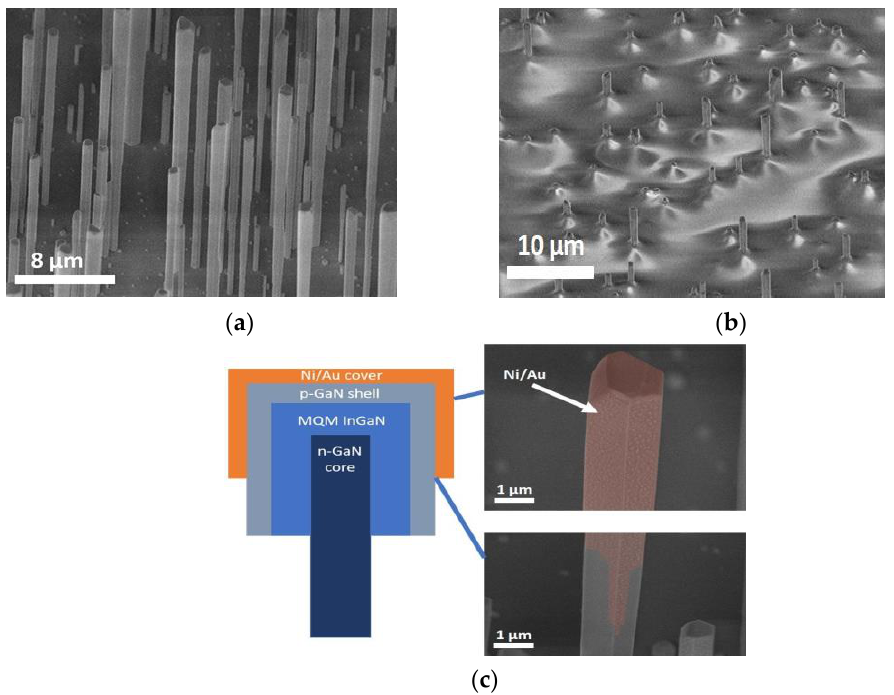
Figure 1. Forty-five-degree tilted SEM images of ( a ) an as-grown MW array, and ( b ) InGaN/GaN microwires encapsulated into PDMS. ( c ) Schematic of InGaN/GaN MQW MW structure with SEM images of a MW tip and the border of an area metalized with Ni/Au (artificial red color denotes metal). The metal layer did not contact MW cores.